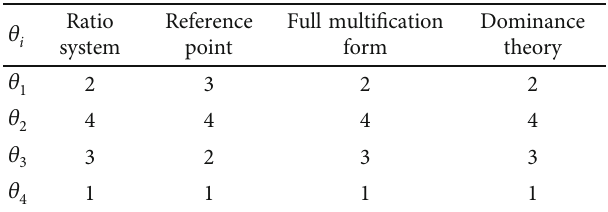
Table 8: CRPAI of CR